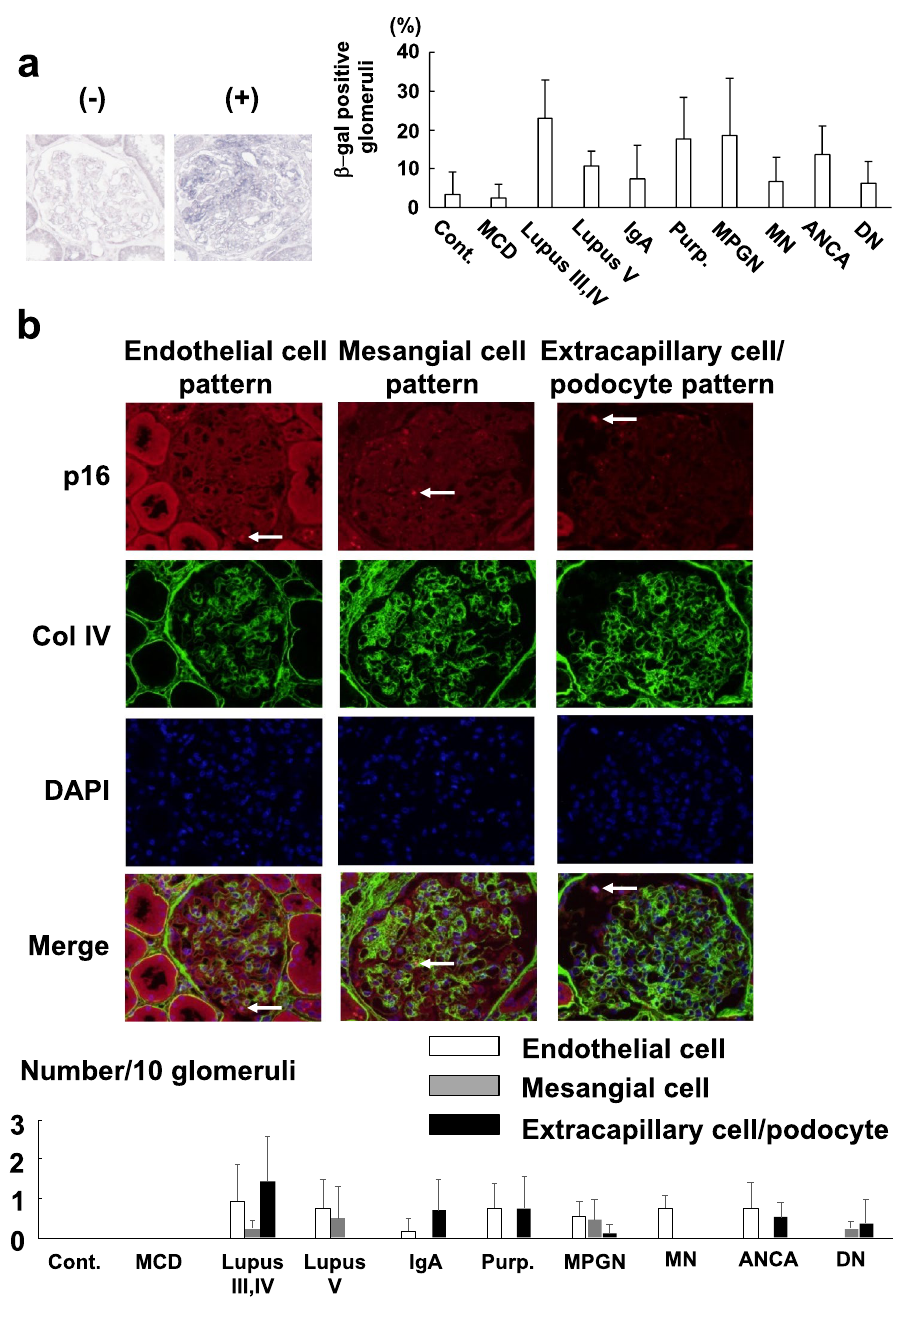
Figure 5. Expression of β-galactosidase and p16 in the glomeruli of patients with kidney diseases. ( a ) β-galactosidase was detected in glomeruli of patients with kidney disease. ( b ) p16 is expressed in endothelial, mesangial cells, and extracapillary cells/podocytes in patients with various human kidney diseases. Representative pictures of each pattern are shown. β-gal: β-galactosidase. Col IV: Collagen IV. Cont.: Control (N = 3). MCD: Minimal change disease (N = 3). Lupus III, IV: Systemic lupus nephritis class III or IV (N = 6). Lupus V: Systemic lupus nephritis class V (N = 3). IgA: IgA nephropathy (N = 6). Purp.: Purpura nephritis (N = 4). MPGN: Membranoproliferative glomerulonephritis (N = 3). MN: Membranous nephropathy (N = 3). ANCA: ANCA glomerulonephritis (N = 6). DN: Diabetic nephropathy (N = 6). White column: Endothelial cells. Grey column: Mesangial cells. Black column: Extracapillary cells and